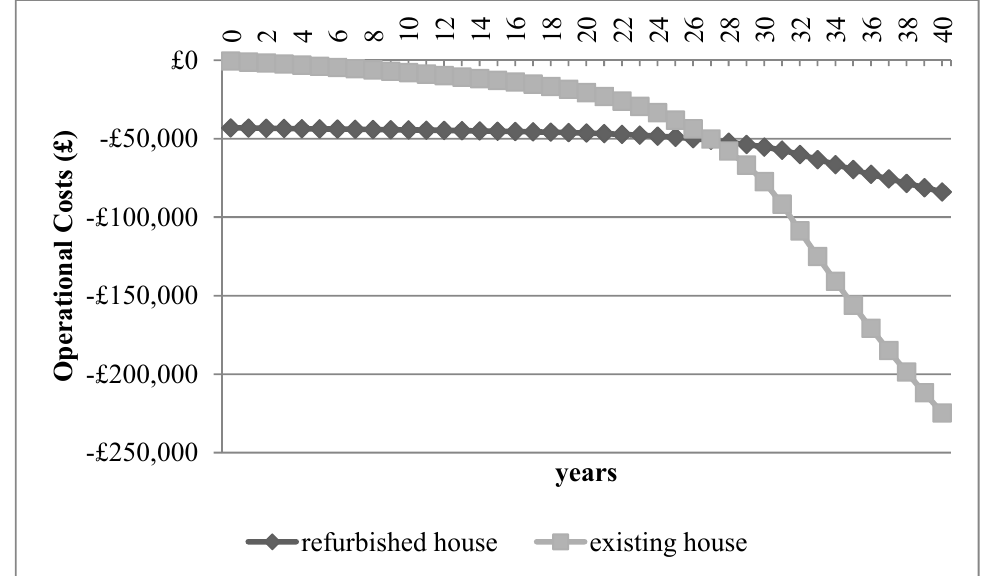
Figure 18. Comparison of the pre and post refurbished house’s cumulative discounted operational costs for London current and future weather data over 40 years imposing an upward gas price